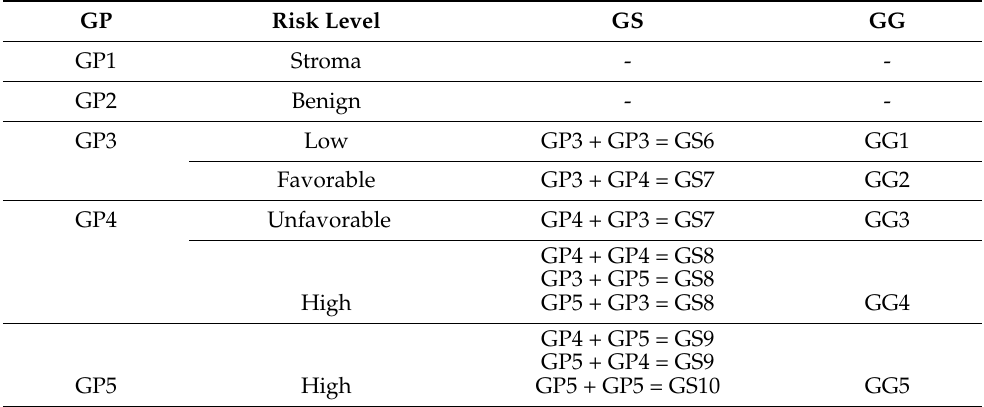
Figure 1. Types of Gleason Pattern (GP), which GP goes from GP1 (stroma) to GP5 depending on the cell differentiated. Table 1. The relation between the Gleason pattern (GP), Gleason score (GS), and grade groups (GG)